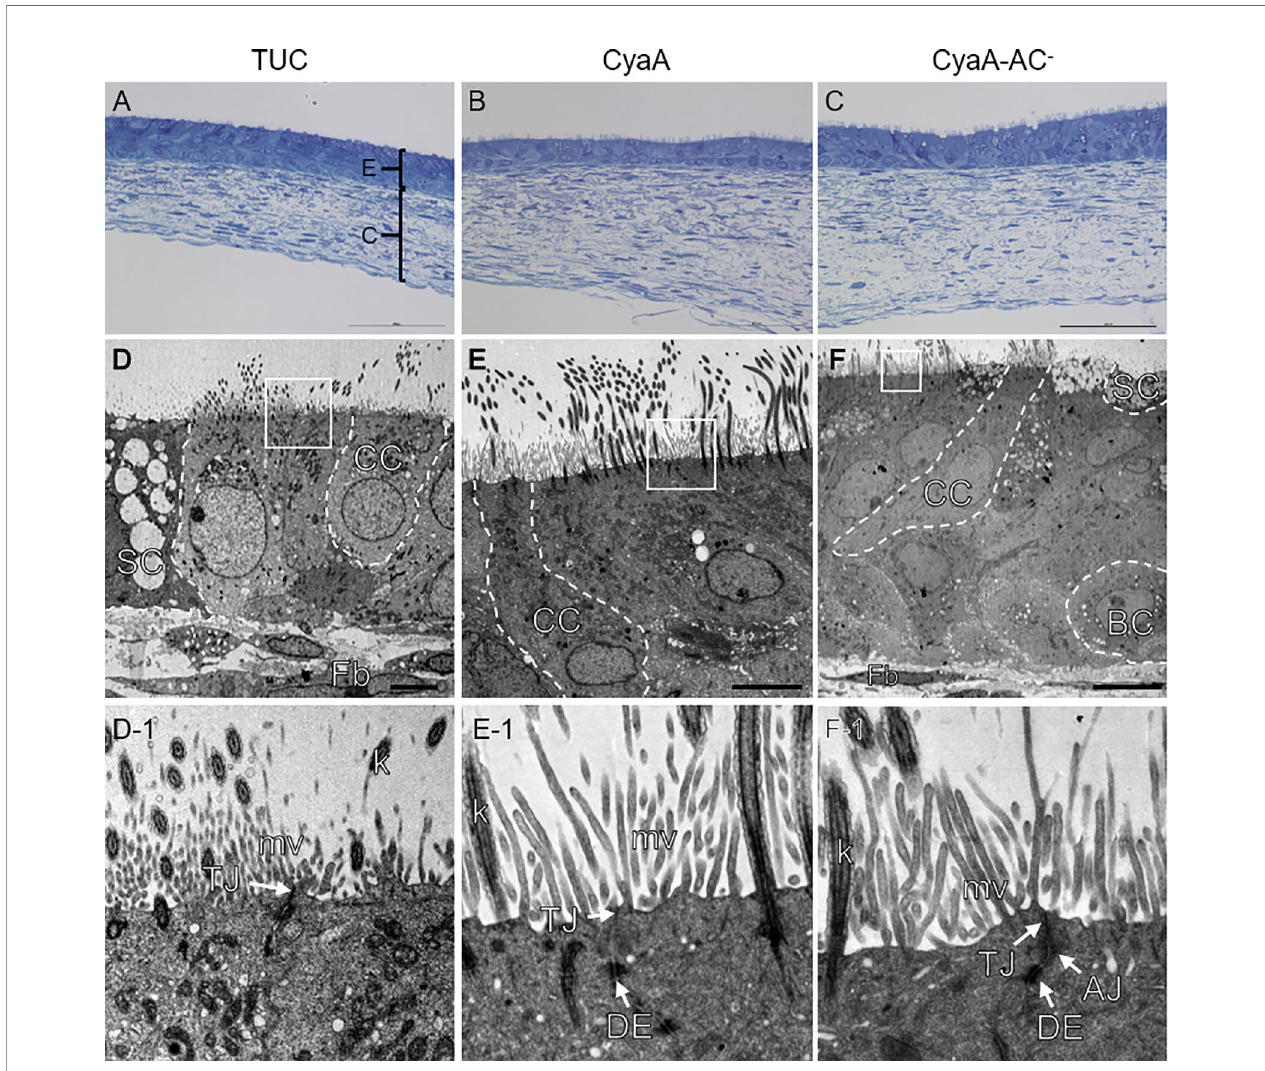
FIGURE 3 | Morphological analysis of nasal mucosa tissue models. Methylene blue staining shows a similar morphology of the tissue models after 1 h TUC (A) , CyaA (B) and CyaA-AC - treatment (C) . Transmission electron microscopic images (D – F) display the mucociliary phenotype of the tissue models and inserts ( D-1 – F-1 ) exemplarily con fi rm intact cell-cell contacts. AJ, adherens junction; BC, basal cell; C, connective tissue; CC, ciliated cell; DE, desmosome; E, epithelial layer; Fb, fi broblast; k, kinocilium; mv, microvilli; SC, secretory cell; TJ, tight junction. Scale bars: (A – C) : 100 µm, (D, E) : 5 µm, (F) : 10